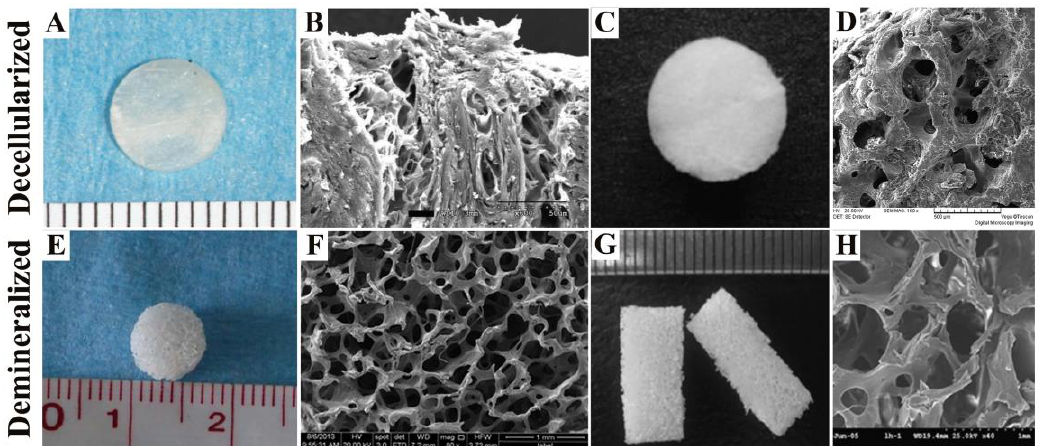
Figure 1. Macroscopic views and scanning electron microscope (SEM) micrographs of decellularized bone and demineralized bone. ( A ) Decellularized rat calvaria. Scale bar: 1 mm. ( B ) The porous structure of decellularized rat calvaria. Scale bar: 50 µ m. ( C ) Cartilage ECM-derived scaffold from human decellularized cadaveric joint of approximately 5 mm in diameter. ( D ) The porous structure of decellularized pig cancellous bone. Scale bar: 500 µ m. ( E ) Decalcified bone of pig. Scale bar: 10 mm. ( F ) The porous structure of decalcified bone from pig. Scale bar: 1 mm. ( G ) Decalcified bone of bovine. Scale bar: 10 mm. ( H ) The porous structure of decalcified bone from bovine. Scale bar: 1 mm.